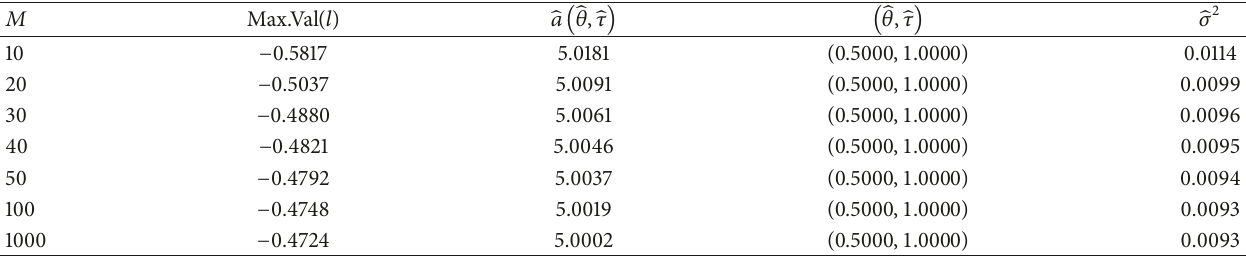
Table 1: Table showing values of Max.Val (𝑙) , of equally spaced time points in [0,10] is 𝑛 + 1 = 101 with ℎ = 0.1 .